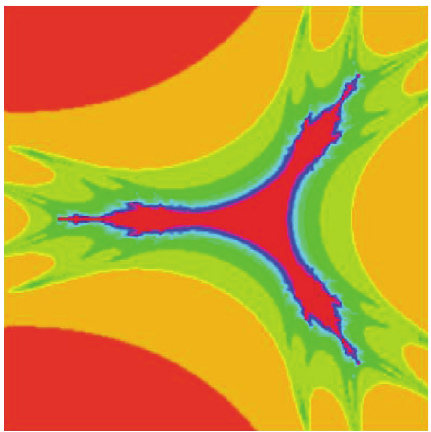
Figure 2: Relative superior tricorn for 𝑠 = 0.2 and 𝑠 󸀠 = 0.4 .